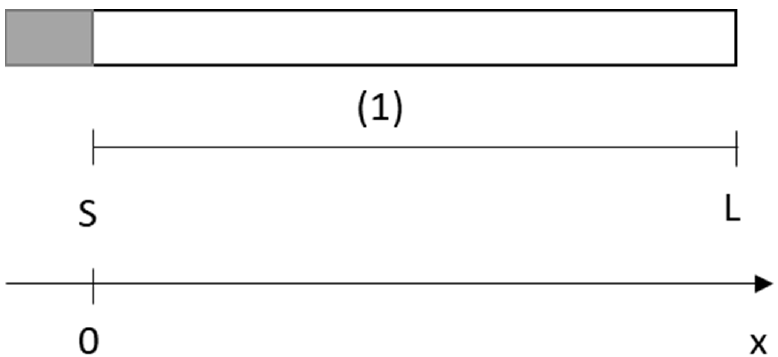
Figure 1. Schematic representation of a lead electrode exposed to a deaered HCl electrolyte. Initially, the thickness of the electrolyte is L and the surface S of lead is at x = 0. The following assumptions are made: the temperature is fixed at 298 K (isothermal conditions), the physical and transport parameters for the species are constant, the metal dissolution is the only anodic reaction, and the proton reduction is the only cathodic reaction occurring in the